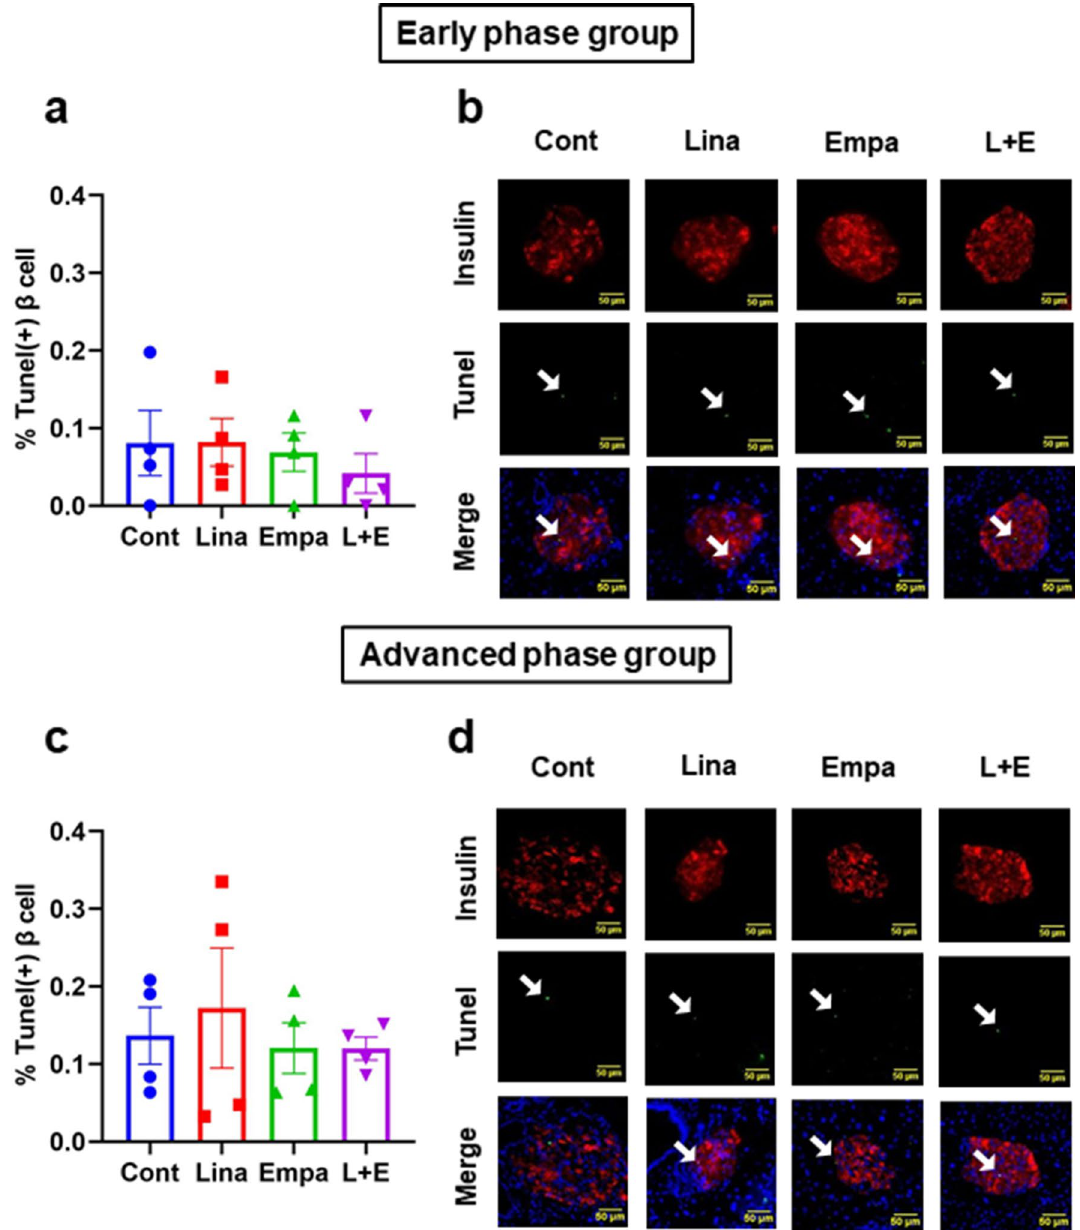
Figure 5. TUNEL assay in ( a , b ) an early phase and ( c , d ) an advanced phase of diabetes. ( a , c ) Quantification of β-cell apoptosis (n = 4). Scale bars: 50 μm. ( c , d ) Representative images of TUNEL positive β-cells. The multiple comparison was performed using the Tukey–Kramer method. Data are presented as mean ± S.D. *: p <